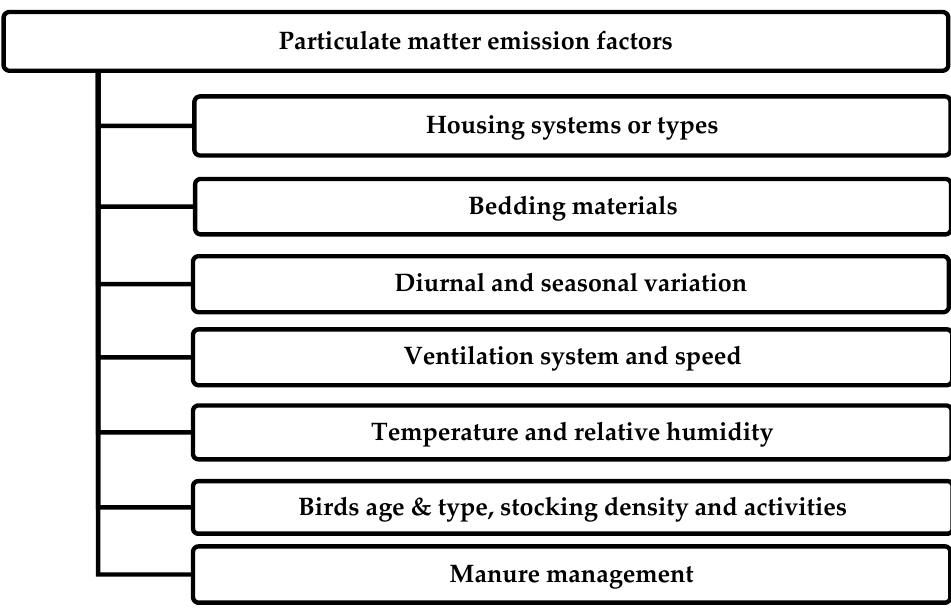
Figure 2. Factors affecting PM emissions in poultry housing.